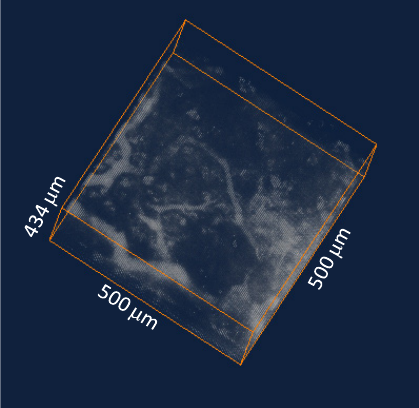
Fig. 3. Vasculature of the subcutaneous tumor with FITC- Dextran as a contrast agent at the depth of 630 (cid:1) m.